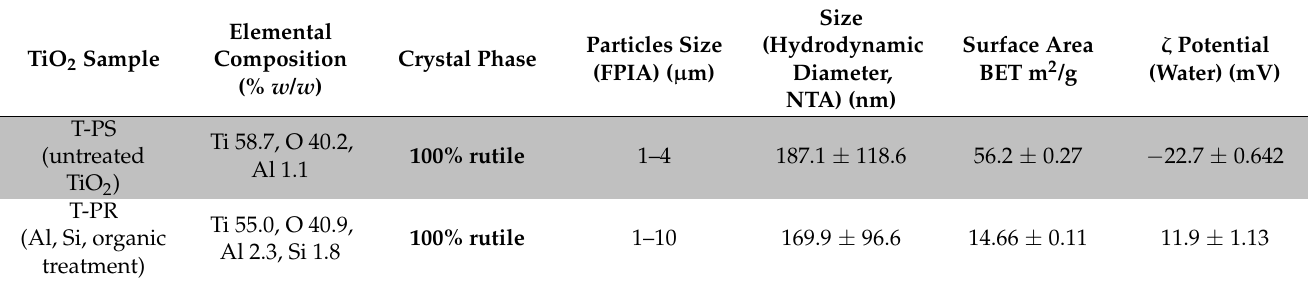
Table 2. Elemental composition, crystallinity, average size (hydrodynamic diameter), dimensional distribution and polydispersion index (PdI) of the various samples of TiO 2